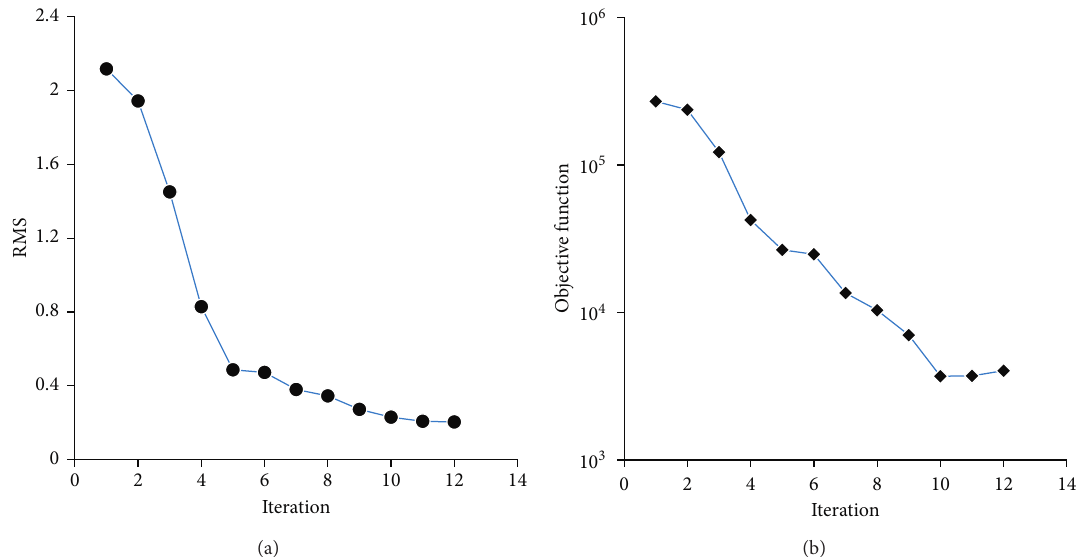
Figure 7: The relationship between inversion parameters and the number of iterations. (a) Data relative fit difference RMS; (b) fitting of objective function.